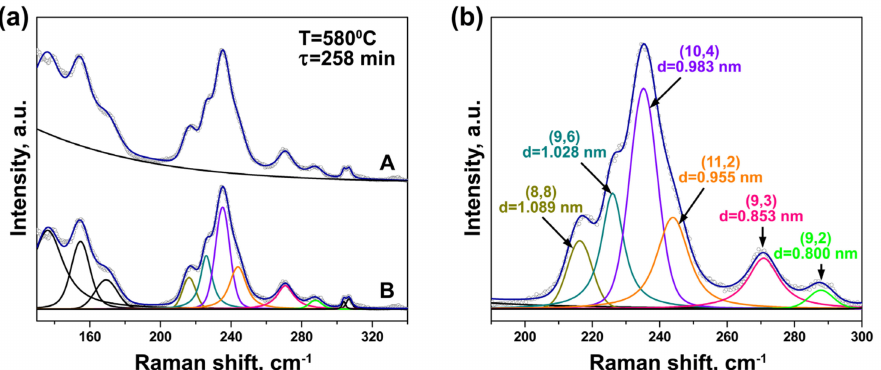
Figure 5. ( a ) The fitting of the RBM-band of the Raman spectrum of the CoCp 2 -filled SWCNTs annealed at 580 ◦ C for 258 min, acquired at a laser wavelength of 568 nm (E ex = 2.18 eV), with the components of individual outer and inner tubes. The spectrum with the fitted background (A) and the same spectrum with the subtracted background fitted with individual components (B). ( b ) The enlarged view of the fitting of the inner tube peaks. The inner tube peaks are labeled.